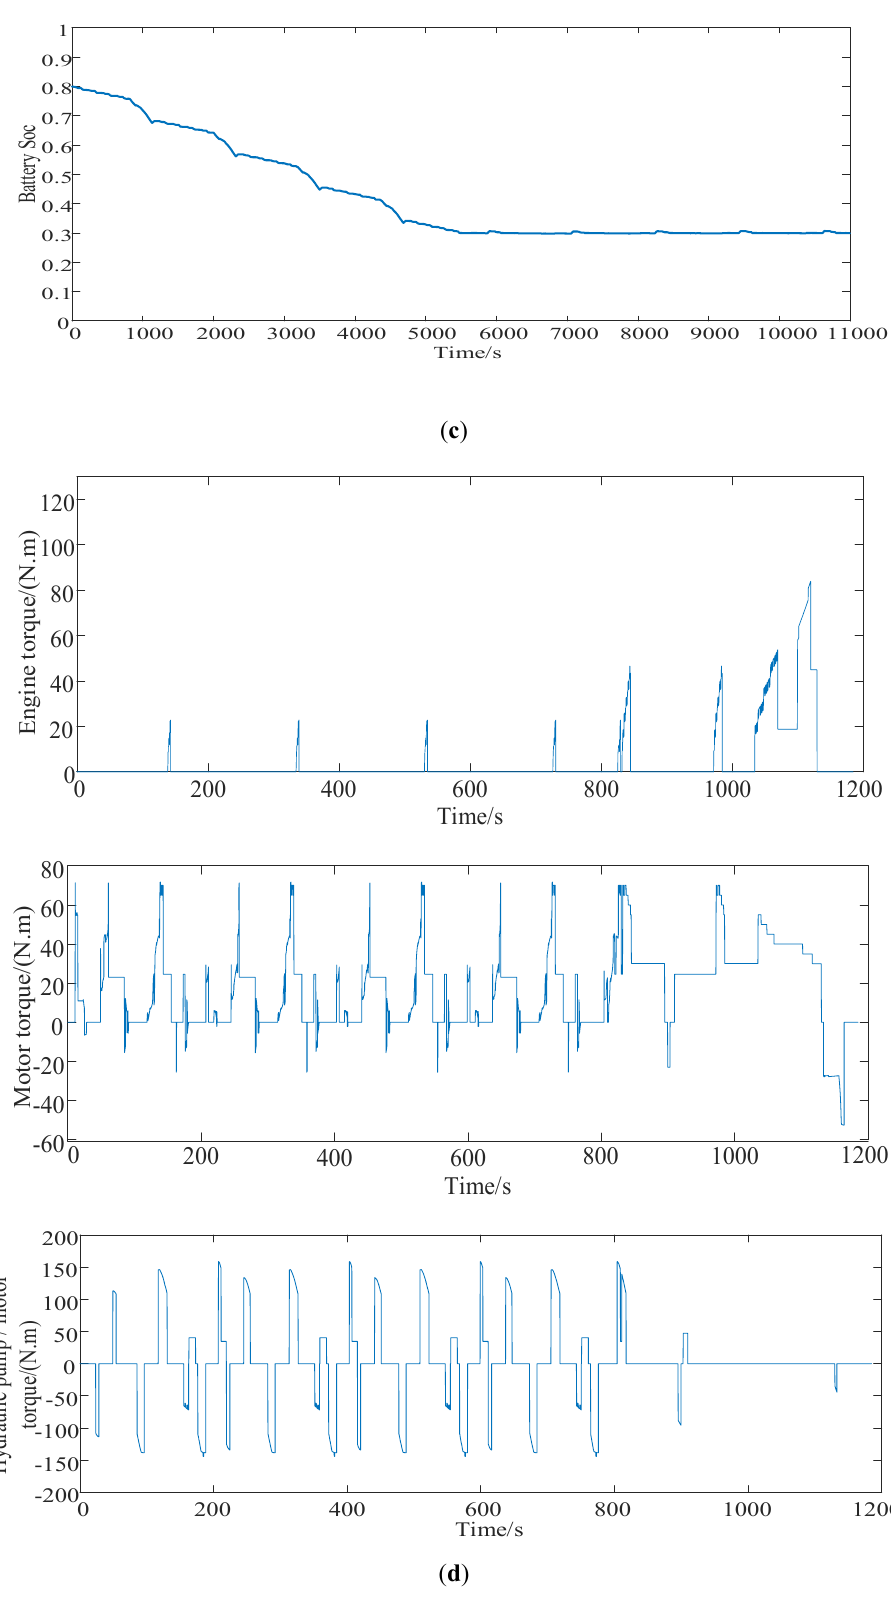
Figure 15. Simulation result: (a) vehicle speed following curve; (b) hydraulic accumulator state of charge (SOC) trajectory curve; (c) battery SOC trajectory curve; (d) torque distribution curve.